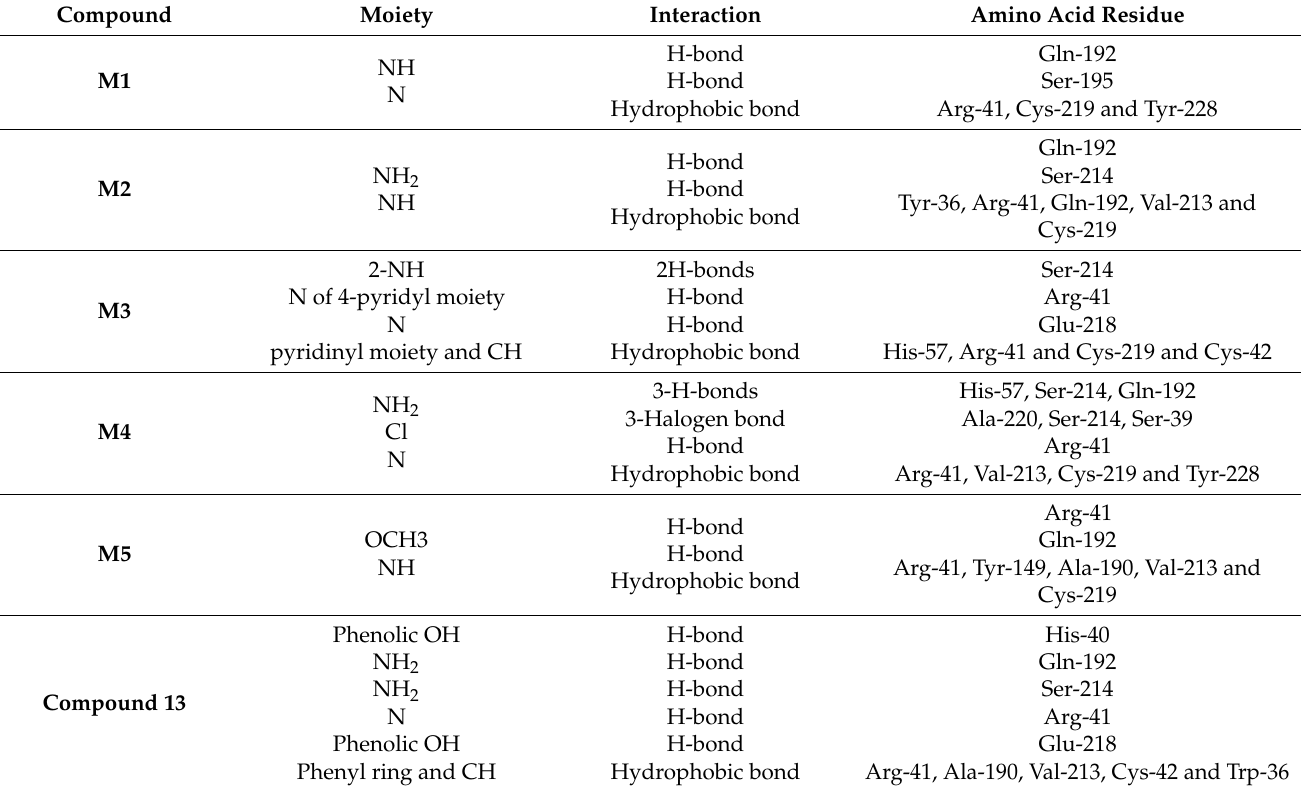
Table 3. Molecular modeling of the shortlisted compounds ( M1 – M5 ) within the binding active site of human TMPRSS2 when compared to Compound 13